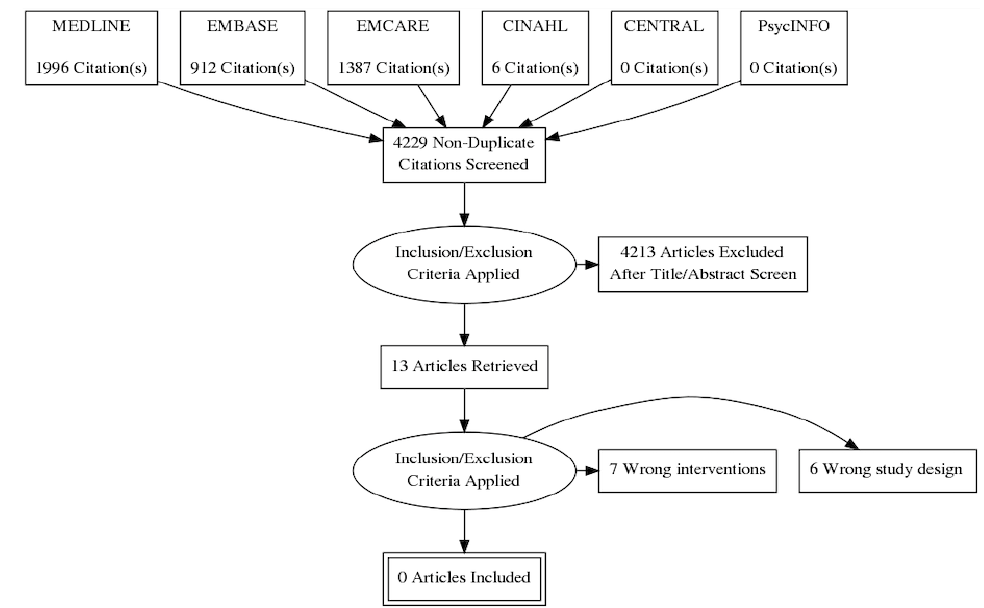
Figure 1. PRISMA flow diagram.